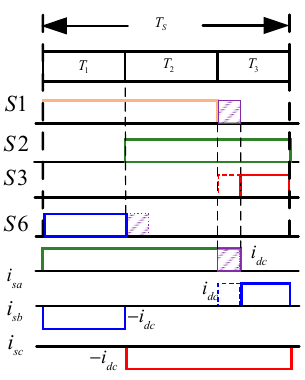
Figure 5. Overlap time effect in sector 1.